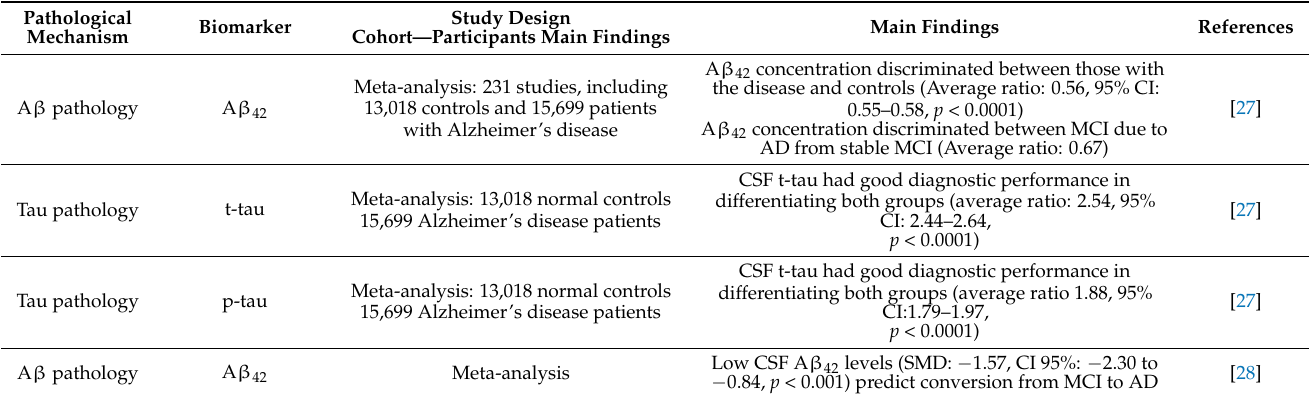
Table 1. Pathological mechanisms (A β and tau pathology) and associated biomarkers of Alzheimer’s disease and the findings of related